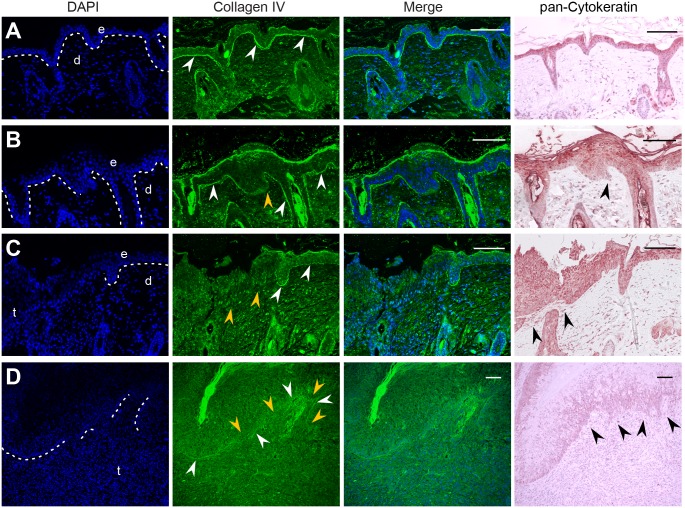
Collagen IV staining on tissue sections reveals invasion of keratinocytes through the basal membrane (BM).The BM was stained against collagen IV (green). Nuclei were counterstained with DAPI (blue). Consecutive sections stained for pan-cytokeratin are shown in comparison. A) In normal skin, the BM (white arrows) marks the barrier between epidermis and dermis. B) Early stage carcinoma formation in UV-irradiated skin. A lack of collagen IV expression indicates the disruption of the BM (orange arrows) accompanied by downward migrating cells (black arrow). C) In the edge region of a UV-induced KSCC, the BM is lost and invading altered keratinocytes are detectable. D) In nKSCC, invasion of neoplastic cells is advanced as indicated by pan-cytokeratin staining. The discontinuous staining of the BM marks transition zones where invading neoplastic squamous cells acquire a spindle cell phenotype (Scale bars: 100 μm).